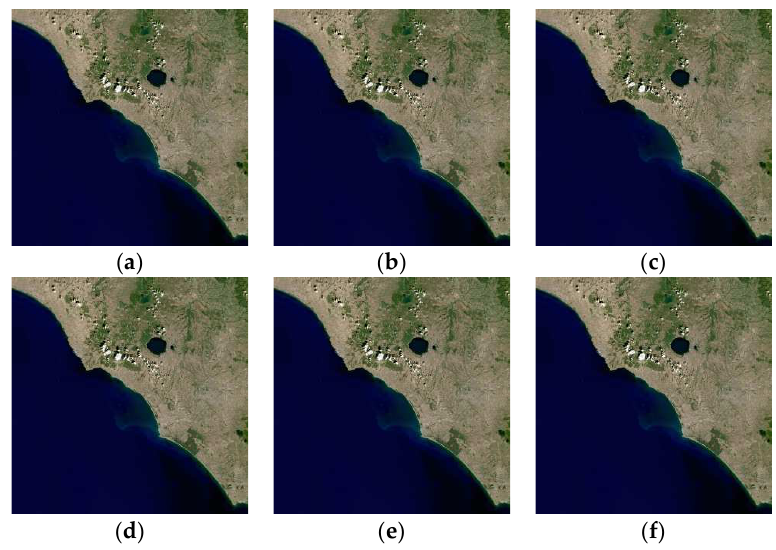
Figure 6. Source image and reconstructed images. ( a ) Source image; ( b ) reconstructed using MFTR; ( c ) reconstructed image (T = 6); ( d ) reconstructed image (T = 6); ( e ) reconstructed image (T = 20); ( f ) reconstructed image (T = 30).